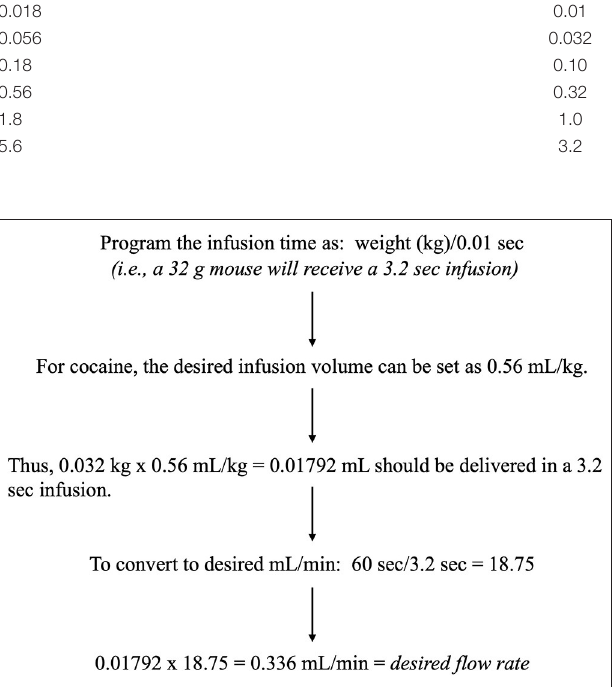
FIGURE 3 | Infusion time calculation. Example formula for infusion time, based on mouse body weight, and desired infusion volume, which are used to calculate the desired flow rate for the set-up of syringe